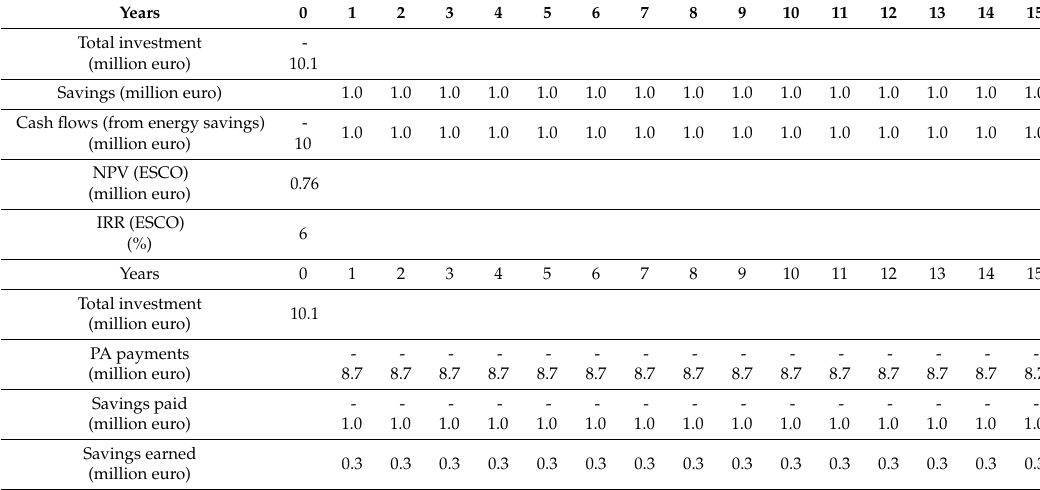
Table A2. Shared savings contract—cash